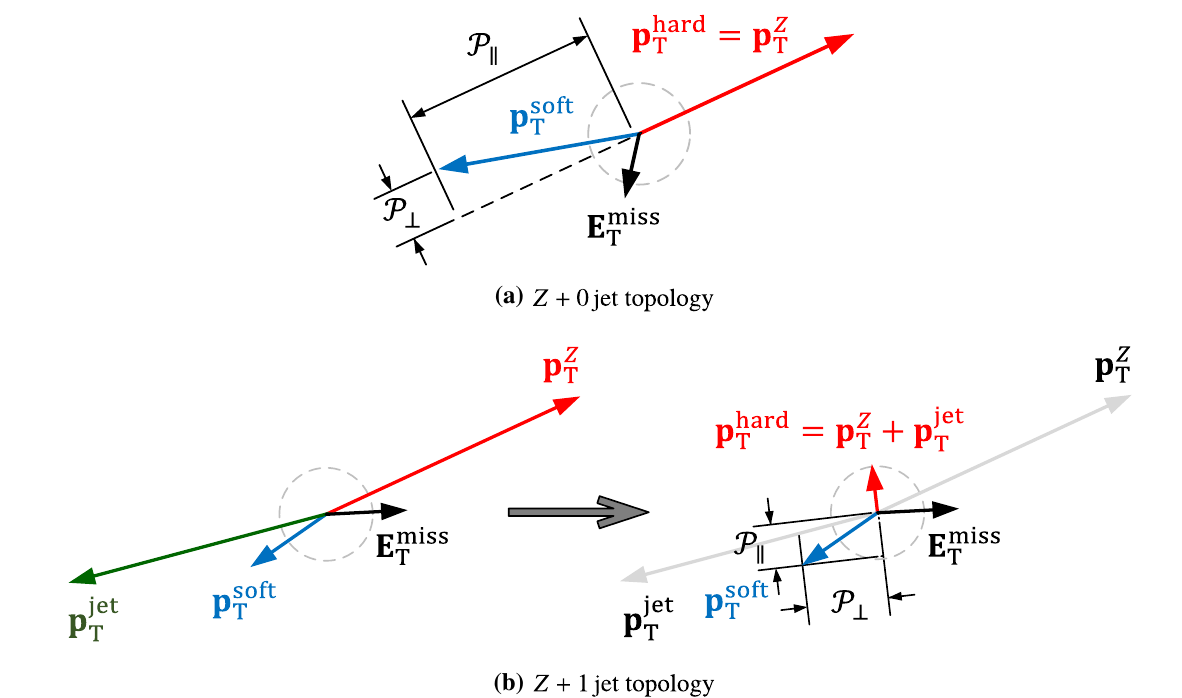
Fig. 12 Schematic view of the parallel ( P (cid:7) ) and perpendicular ( P ⊥ ) projections of p soft on p hard for Z → μμ events without genuine E miss T T for a a final state without any jets and b a final state with one jet. The